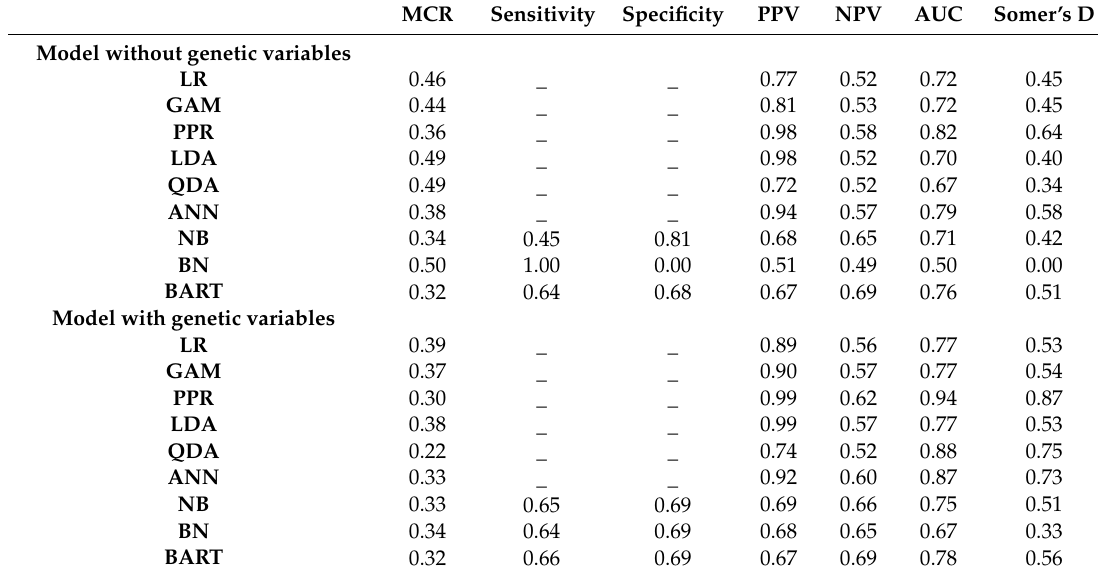
Table 3. Indicators of classification ability of the model both with and without genetic variables. Values for LR, GAM, PPR, LDA, QDA, and ANN are the same reported in Giachino et al. [14]. MCR Sensitivity Specificity PPV NPV AUC Somer’s D Model without genetic variables LR 0.46